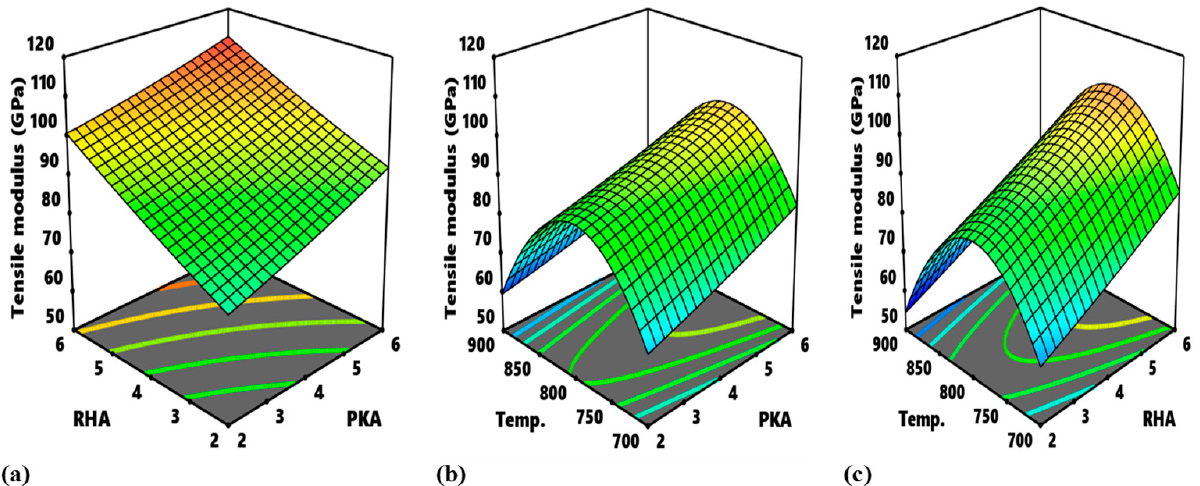
Figure 10. Surface plots representing the relationship of the variables affect tensile modulus as revealed by interactions ( a ) PKA vs. RHA ( b ) PKA vs. stirring temperature ( c ) RHA